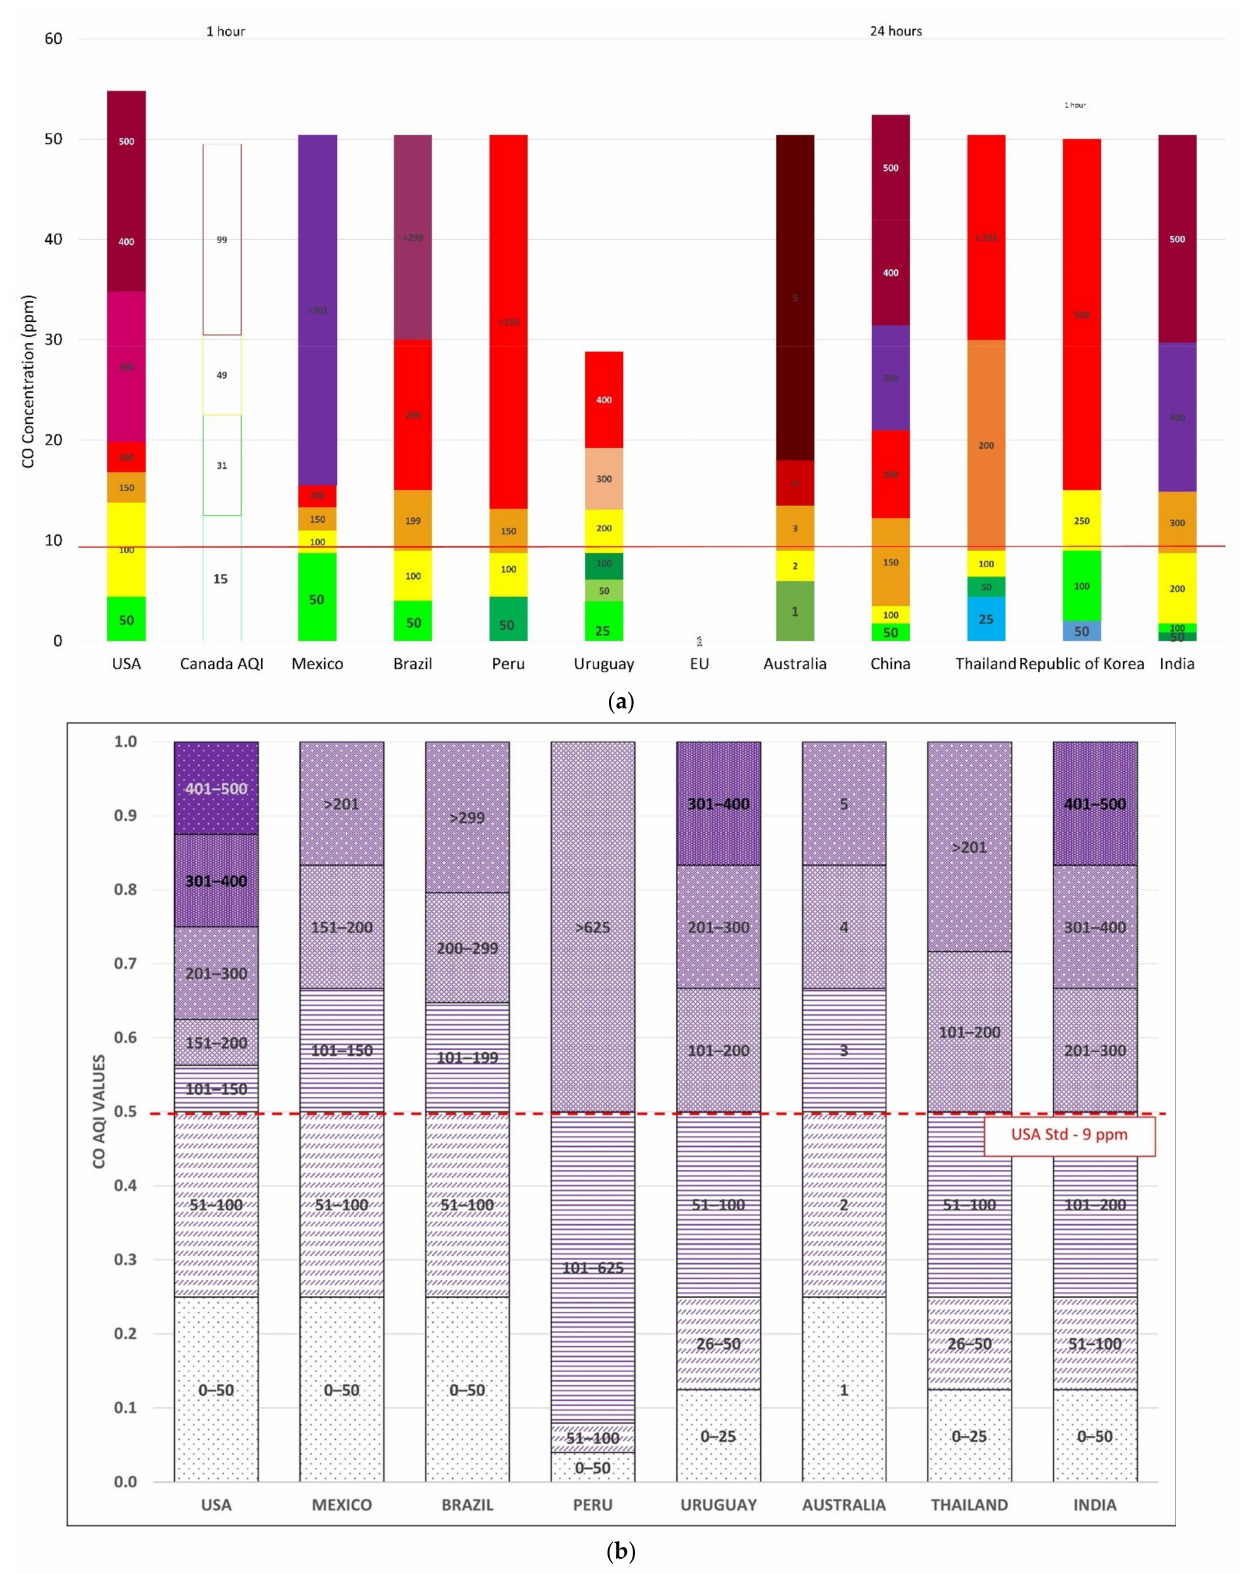
Figure 6. ( a ) CO concentration corresponding to AQI classes in different countries (above the bars, the averaging periods when different from 8 h). The red line represents the USA standard value. ( b ) Normalized CO AQI values (based on 8-h averaged